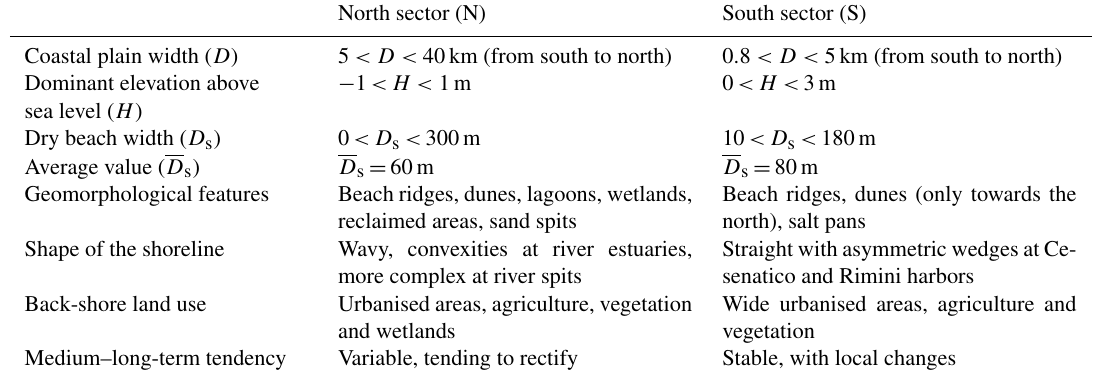
Table 1. Summary of the physical characteristics of the E-R coast. The N and S sectors are defined in Fig.